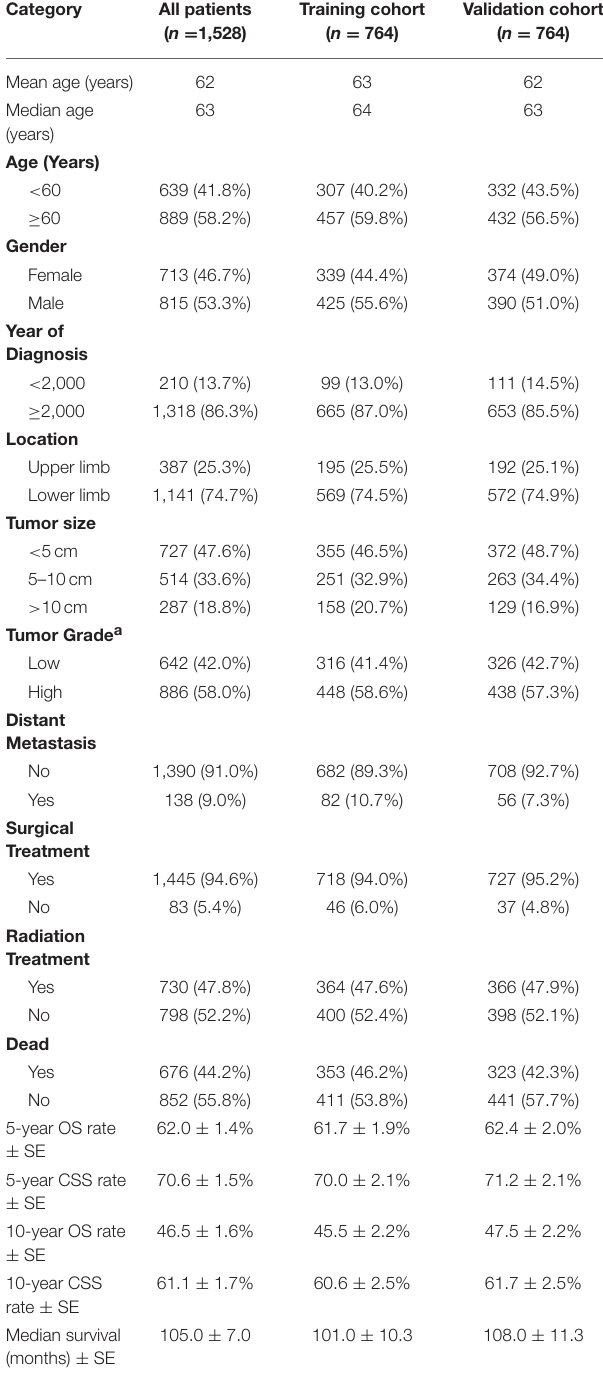
TABLE 1 | Baseline demographics and clinical characteristics of the patients with soft tissue extremity